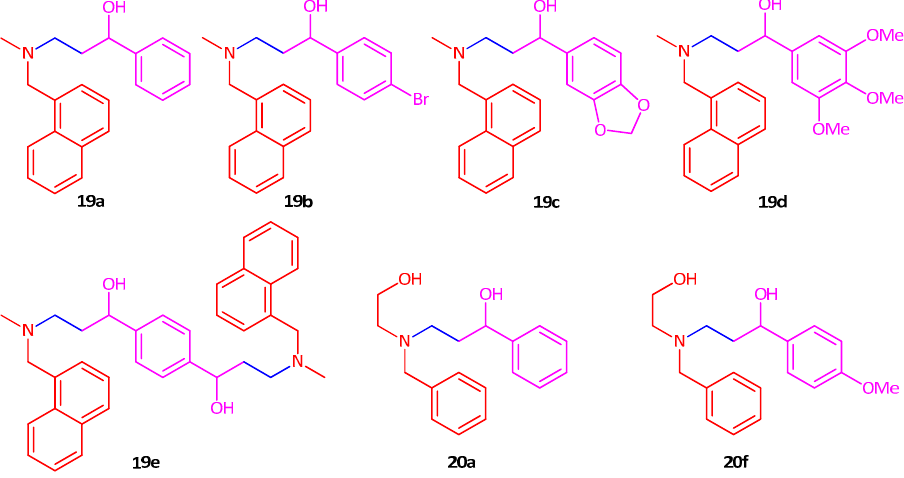
Figure 4. Set of γ -aminoalcohols 19 – 20 obtained via a one-pot S N /reduction sequence from amines 13f and 13h and propiophenone salts 17a – f .